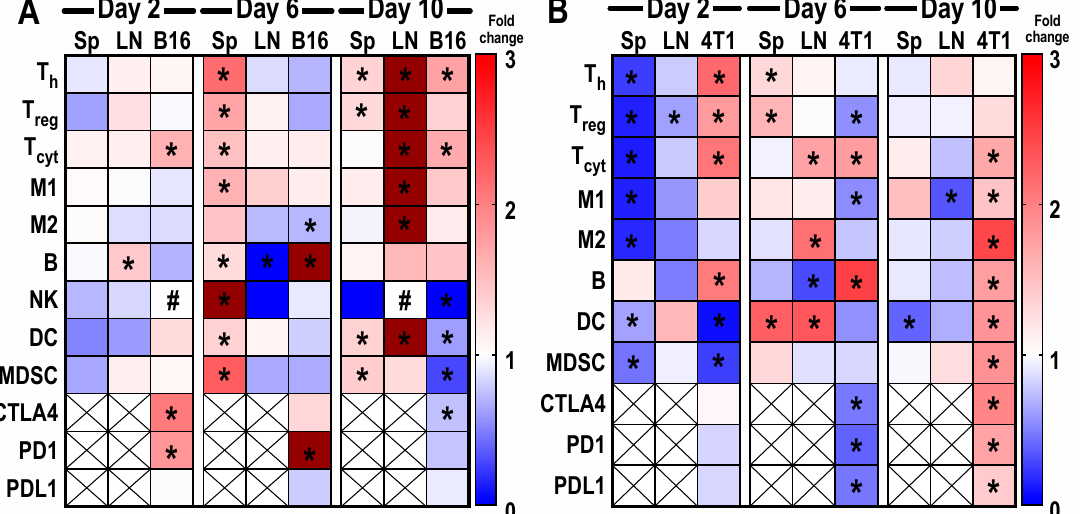
Sp LN B16 Sp LN B16 Sp LN B16